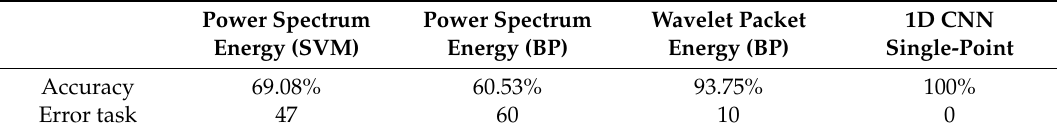
Table 4. 2-D CNN multi-measurement point reciprocating compressor gas valve fault diagnosis model